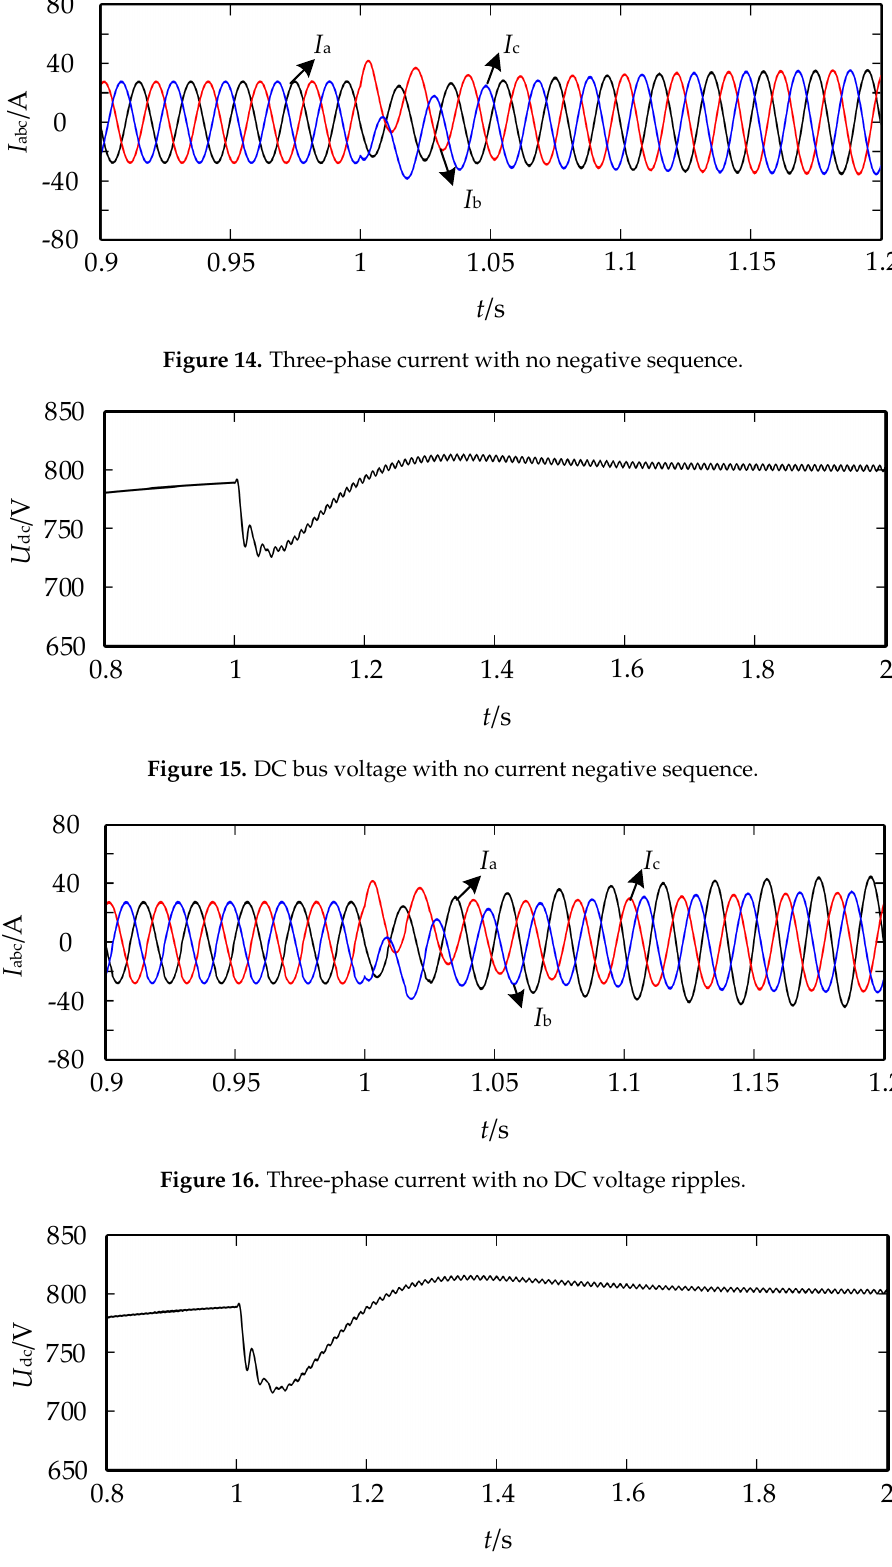
Figure 14. Three ‐ phase current with no negative sequence.